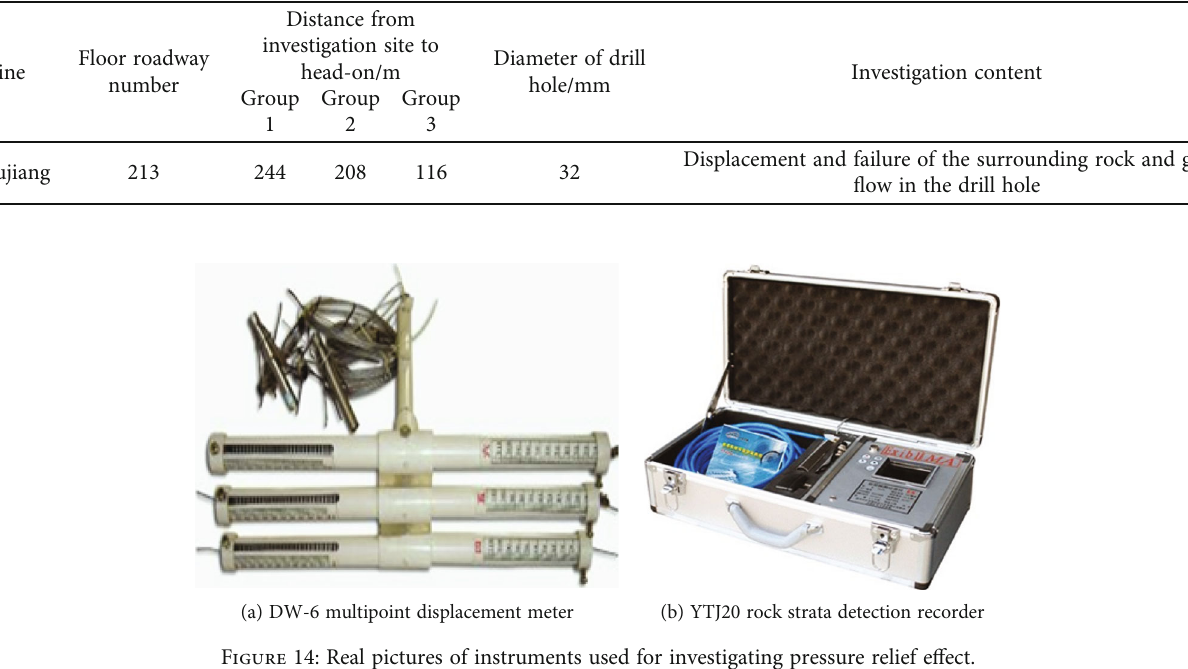
Table 2: Investigation sites of pressure relief e ff ect.